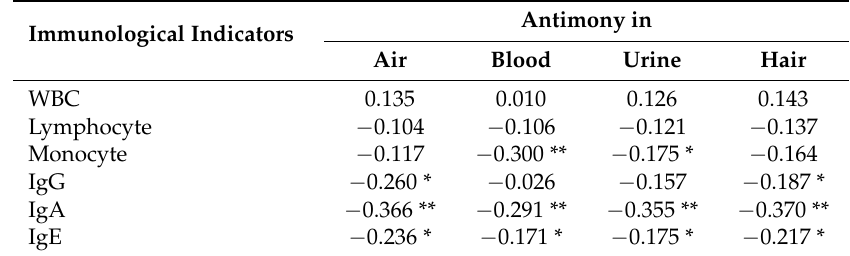
Table 4. Spearman’s correlation coefficients of antimony exposure levels and immunological indicators of all study participants. ( N =